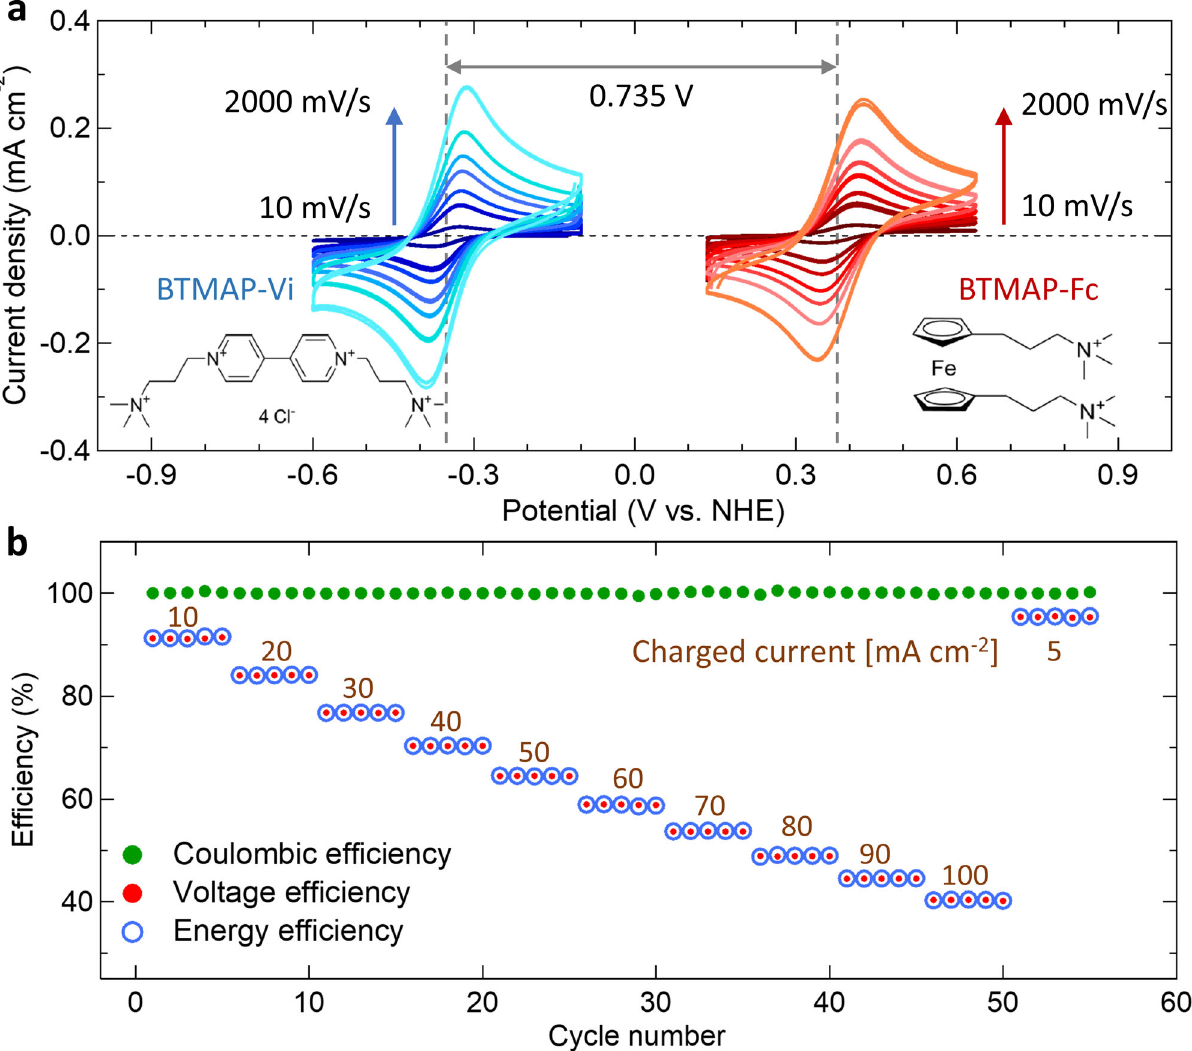
Fig. 2 CV and RFB cycling performance of BTMAP-Vi and BTMAP-Fc. a CV of 5 mM BTMAP-Vi (blue curve) and 5 mM BTMAP-Fc (red curve) at the scan rates of 10, 100, 200, 400, 600, 1000, and 2000 mV s − 1 (color from dark to light). b Coulombic ef fi ciency (green dots), voltage ef fi ciency (red dots) and energy ef fi ciency (blue circles) of the RFB cycled galvanostatically with 0.20 M BTMAP-Vi and 0.20 M BTMAP-Fc at different current densities of 5 – 100 mA cm − 2 and cut-off voltages of 1.1 and 0.3 V. 1.0 M NaCl was used as the supporting electrolyte for both redox couples in the CV and